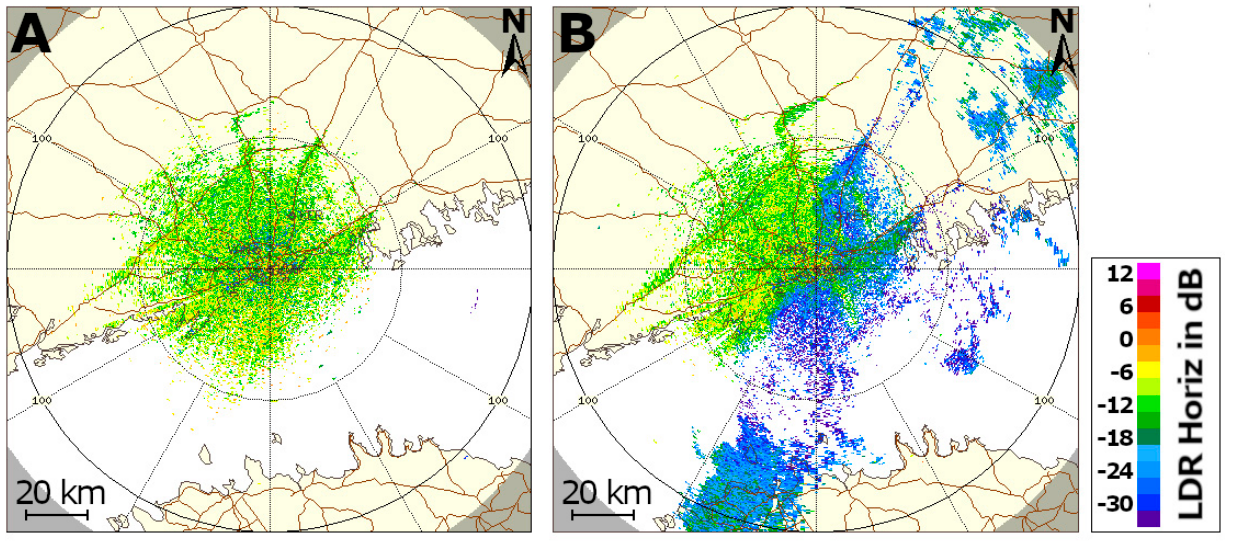
Figure 5. Linear depolarisation ratio (LDR) on 3 Oct 2007 18:34 UTC ( A ) and 5 Oct 2007 19:34 UTC ( B ), showing bird migration as yellow-green area and precipitation in blue.